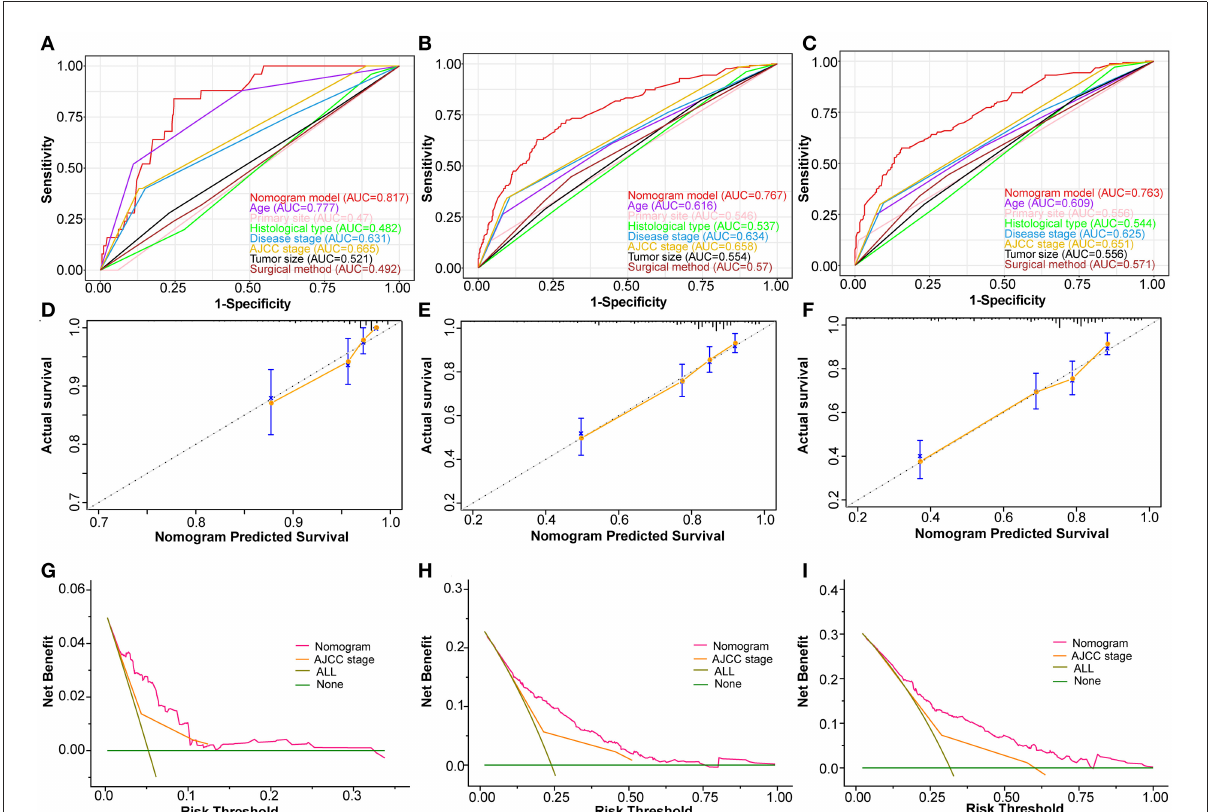
FIGURE4 Validating the prognostic nomogram in the validation cohort. Receiver operating characteristic curves (ROC) for 1 (A) , 3 (B) , and 5 (C) years in the validation cohort, comparing the predictive ability between the nomogram and all independent factors, including age, primary site, histological type, disease stage, AJCC Stage, tumor size, and surgery. The calibration curves of the nomogram for 1 (D) , 2 (E) , and 3 (F) years in the validation cohort. The decision curve analysis of the nomogram for 1 (G) , 2 (H) , and 3 (I) years in the validation cohort, comparing the predictive ability of the nomogram with the AJCC